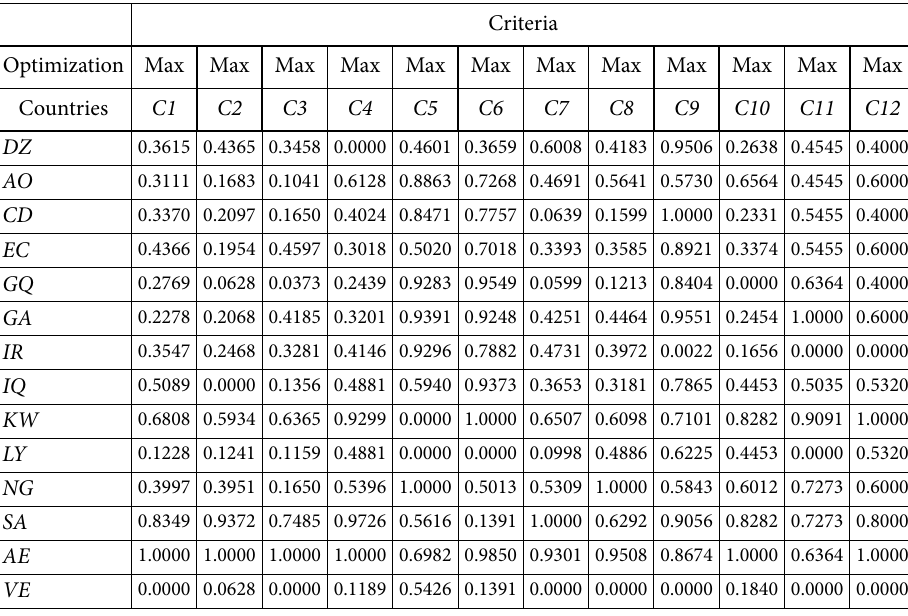
Table 4. Linear normalization values